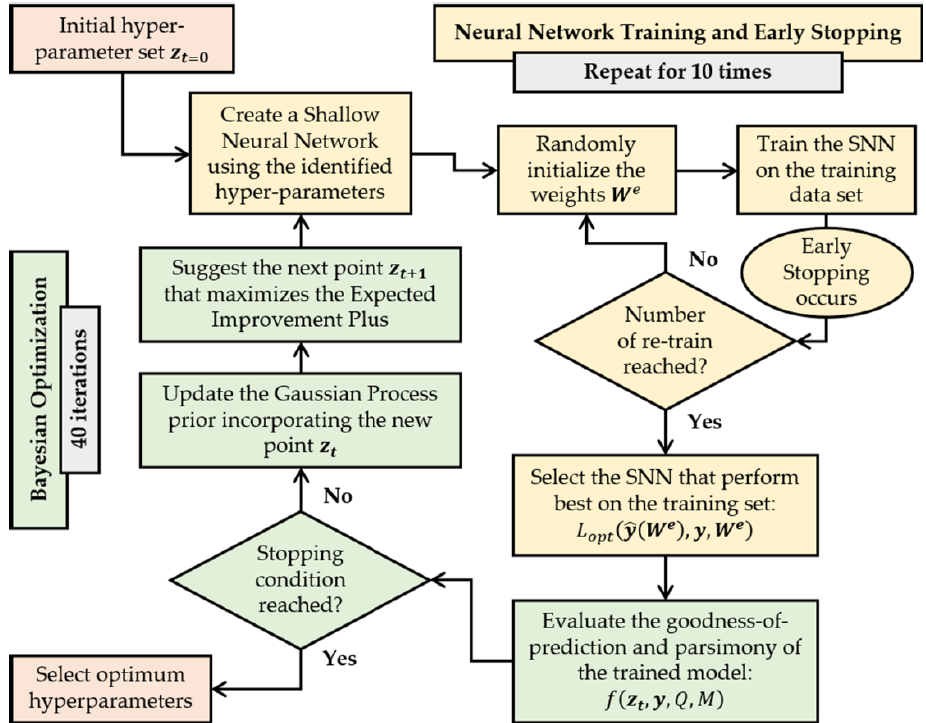
Figure 4. Flow chart of the optimization procedure.